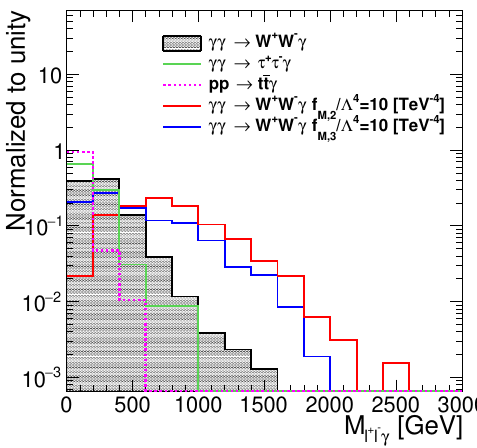
Figure 9 . The invariant mass distribution of l 1 l 2 (cid:13) , measured in the central detector. The SM backgrounds are indicated in shaded gray, solid green and dashed purple histograms. The red and blue histograms show the two samples of dimension-8 coupling f M; 2 = (cid:3) 4 = f M; 3 = (cid:3) 4 = 10 TeV (cid:0) 4